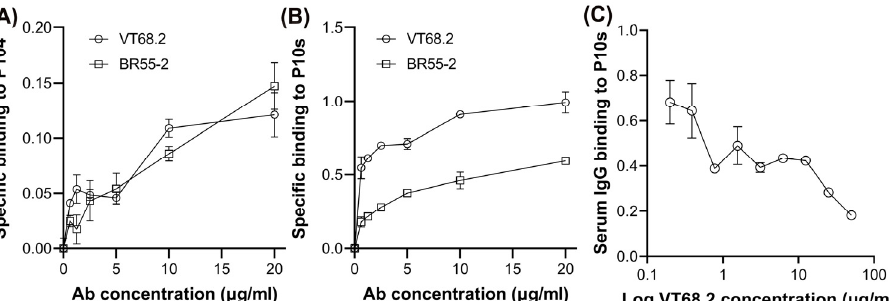
Figure 3. VT68.2 mAb binds to LeY-mimicking peptides and inhibits the binding of anti-P10s serum antibodies to P10s. VT68.2 and anti-Lewis Y mAb BR55-2 react with P104 ( A ) and P10s ( B ). ELISA plates were coated overnight with the peptides, and reactivity of serial dilutions of the mAbs was detected. Background binding was subtracted. ( C ) ELISA plates were coated with P10s overnight, as described above. After blocking, plates were incubated with serial dilutions of VT68.2 mAb. Plates were then washed and incubated with post-immune serum from a patient immunized with conjugated P10s. The binding of IgG in patient serum was detected using an HRP-conjugated anti-human IgG antibody. Means ± SDs are shown.